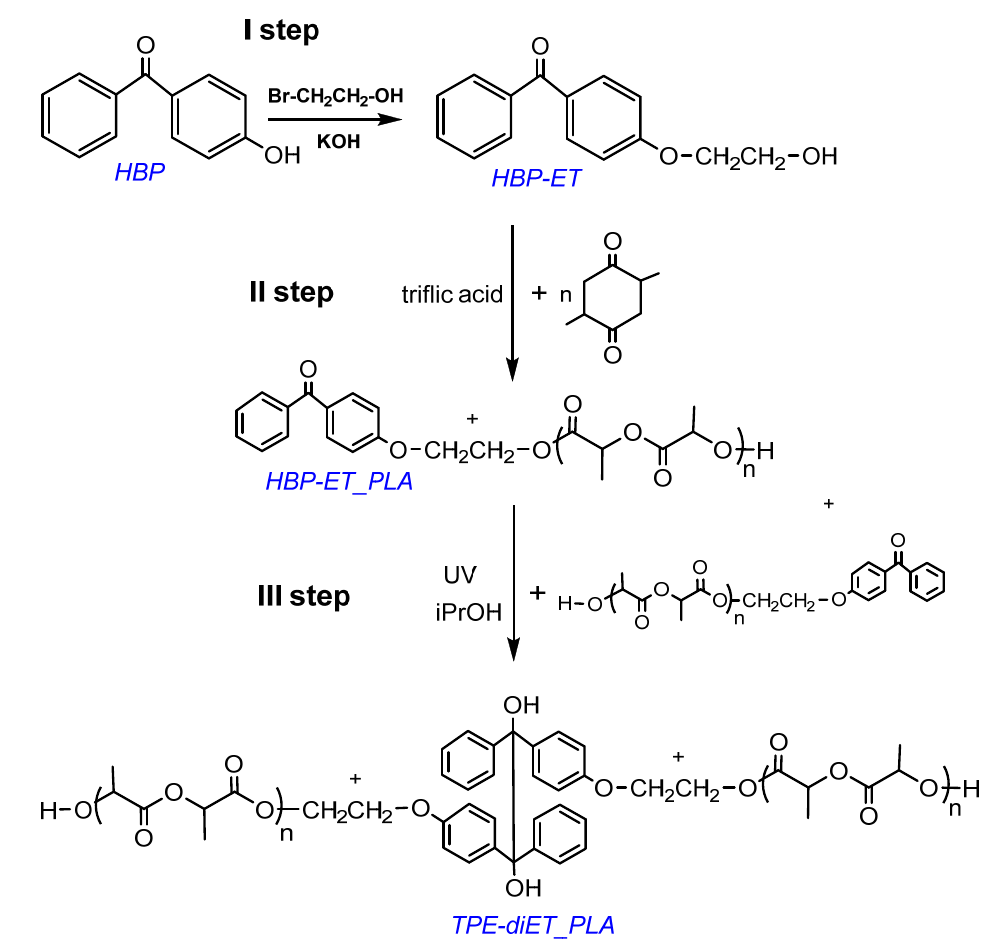
Figure 2. Scheme for the synthesis of PLA with one TPE group in the middle of the chain. The successful functionalization of 4-hydroxybenzophenone to 4-(2-hydroxyethoxy) benzophenone (HBP-ET) was confirmed by 1 H NMR analysis (see Figure S1 in Supporting Information). HBP-ET containing primary hydroxyl groups was used for the initiation of L , L -lactide polymerization, which was catalyzed by triflic acid. PLAs with three different molecular weights were obtained. The molecular weights were M n = ~700, 1100, and 1600 (M n determined by 1 H NMR, Figure 3, Figures S2 and S3). These polymers possessed a benzophenone moiety at one chain end and were dissolved in a solvent that contained isopropanol as a hydrogen atom donor, and they were subjected to UV radiation, which resulted in the coupling of two PLA chains and the formation of a tetraphenylethane group in the middle of the polymer chain. The expected structure of the coupled PLAs was confirmed by 1 H NMR, 13 C NMR, 1 H 13 C-HMBC correlation, and FT IR analyses (Figure 3, Figures S2–S6).